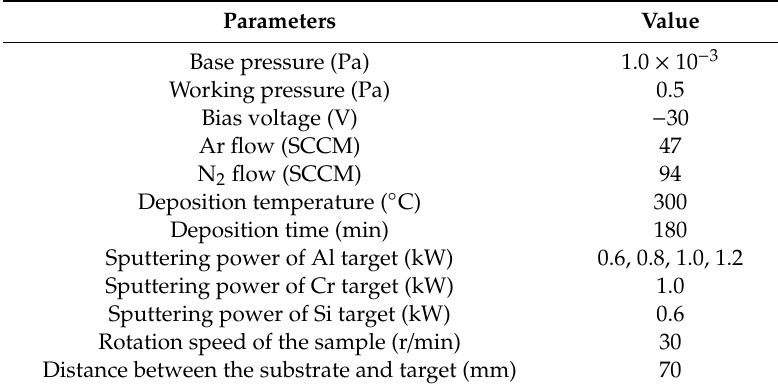
Deposition parameters of the four CrAlSiN coatings deposited under di ff erent Al sputtering